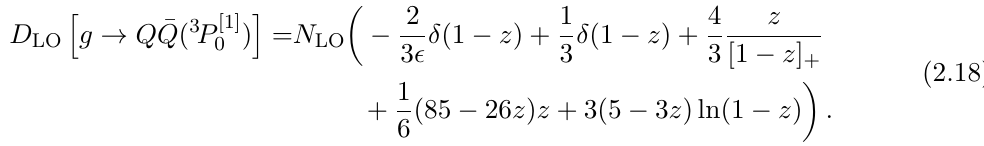
Figure 2 . Typical Feynman diagrams without gluon eikonal vertex for g → Q ¯ Q ( 3 P [1] gray circles in the last four diagrams represent the loop of the light particles such as the gluon, the light quarks and the ghost. The other diagrams can be obtained by permuting the heavy quark and anti-quark. The real and virtual diagrams can be obtained by cutting at different